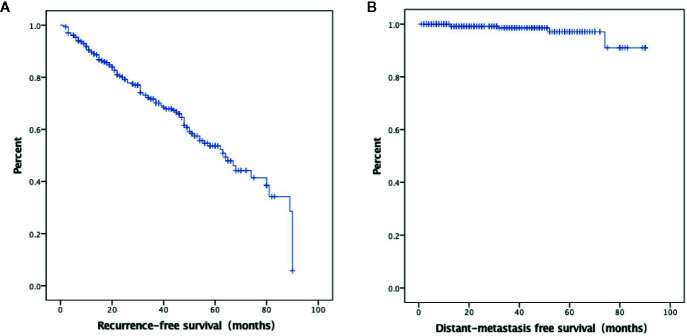
Kaplan–Meier curves showing excellent response survival (A) and distant metastasis-free survival (B).